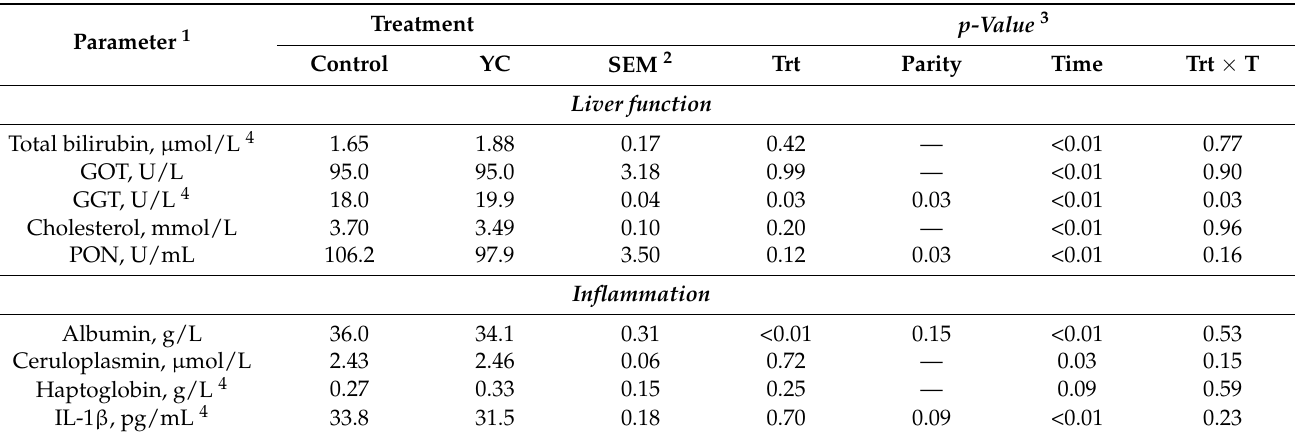
Table 1. Blood biomarkers related to liver function and inflammation for dairy cows fed a basal diet (Control) or a basal diet supplemented with a yeast culture fermentation product (YC) from − 31 ± 6 d relative to calving through 50